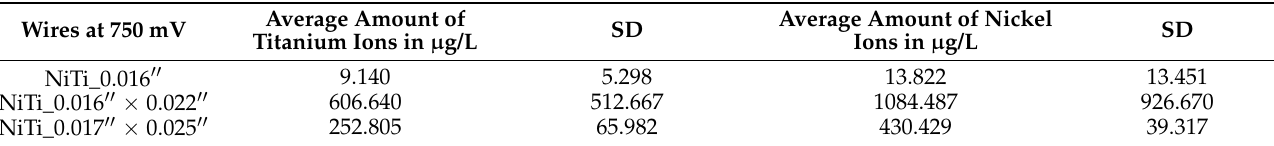
Table 11. The average amount of Ti and Ni ions being measured when 750 mV was applied on the three different dimensions of the NiTi wires.